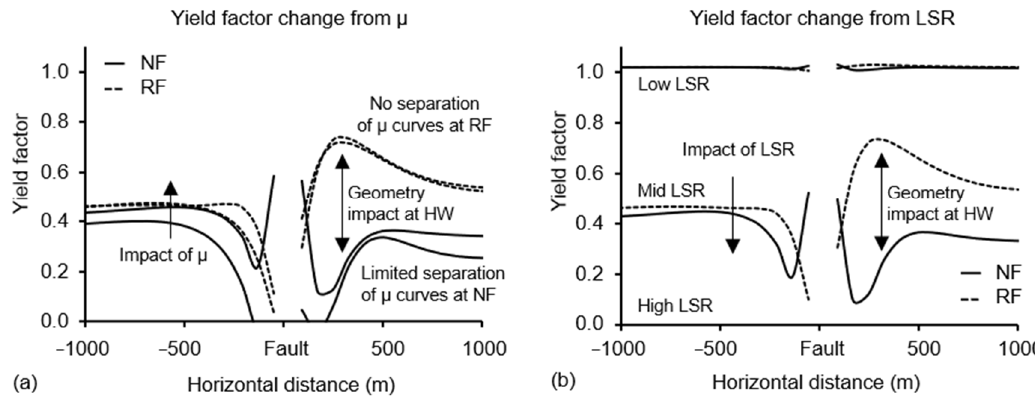
Figure 9. Changes in the yield factor from changes ( a ) of the fault friction µ and ( b ) of the LSR